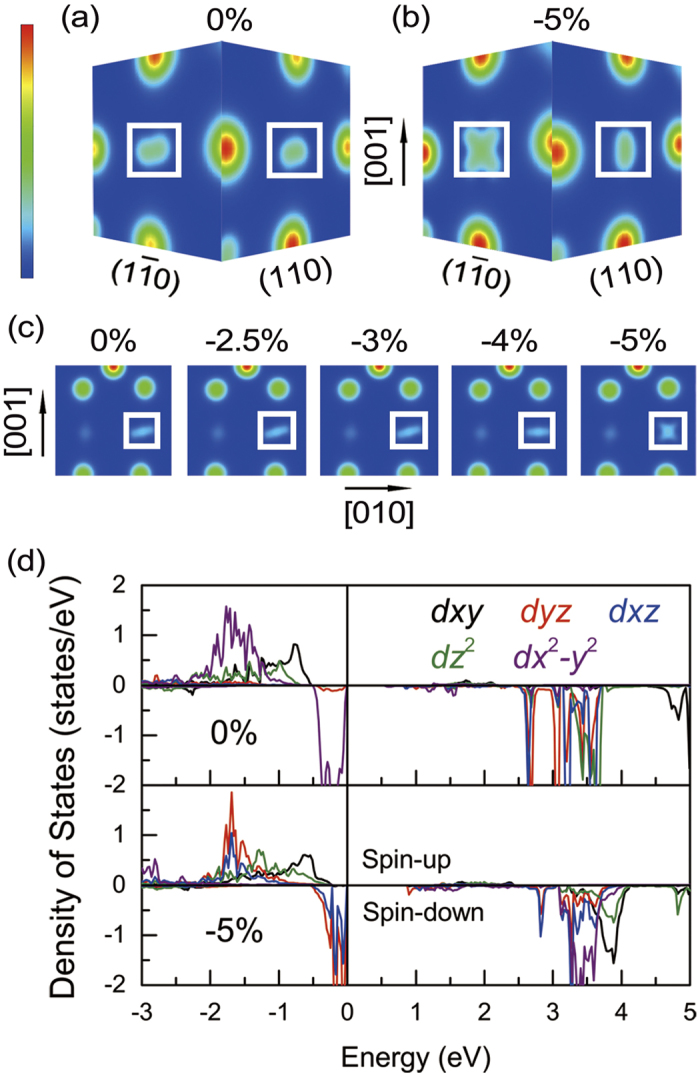
Charge density of B4t2g↓ plotted on  and (110) planes in structure (I) with (a) 0% and (b) −5% lattice strain are shown, respectively. Charge density of B4t2g↓ plotted on (100) plane for 0%, −2.5%, −3%, −4% and −5% lattice strain are showing in (c). The atom shown in white square is Fe (B4). The PDOS of Fe(B4) plotted on 3d orbits with 0% strain (upper panel) and −5% (lower panel) are shown in (d).